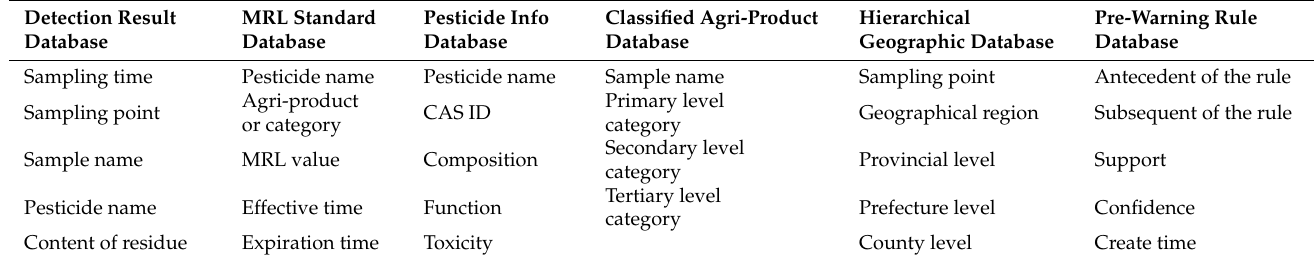
Table 1. Main properties of six databases.